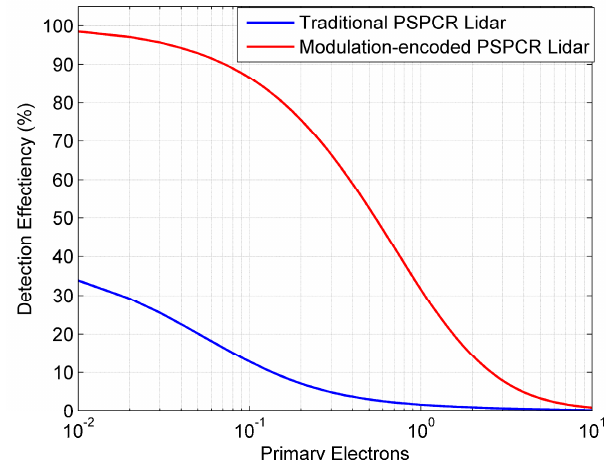
Figure 6. The signal photon detection efficiency of the traditional PSPCR Lidar and modulation-encoded PSPCR Lidar at different primary photoelectron number.